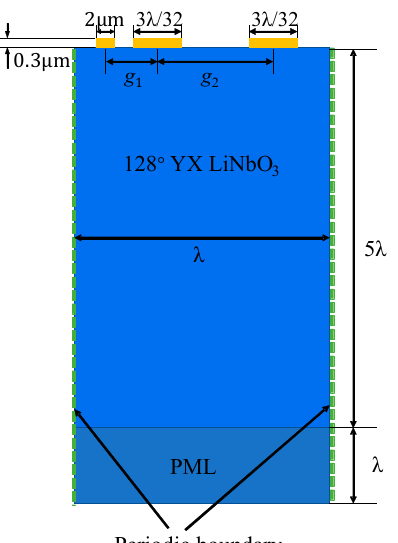
Figure 3. Reflectivity per period of Al electrodes on 128° YX LiNbO 3 substrate.